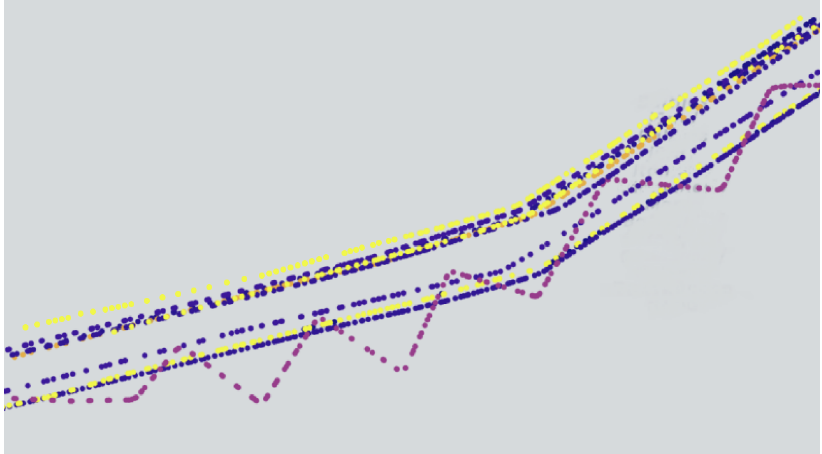
Figure 15. A demonstration of all locations of ships reported through AIS system.